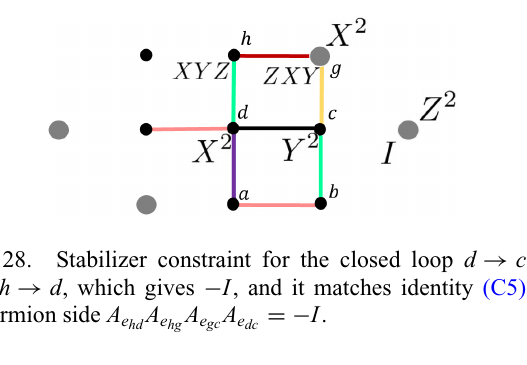
= − I A e A e A e gc hd hg dc